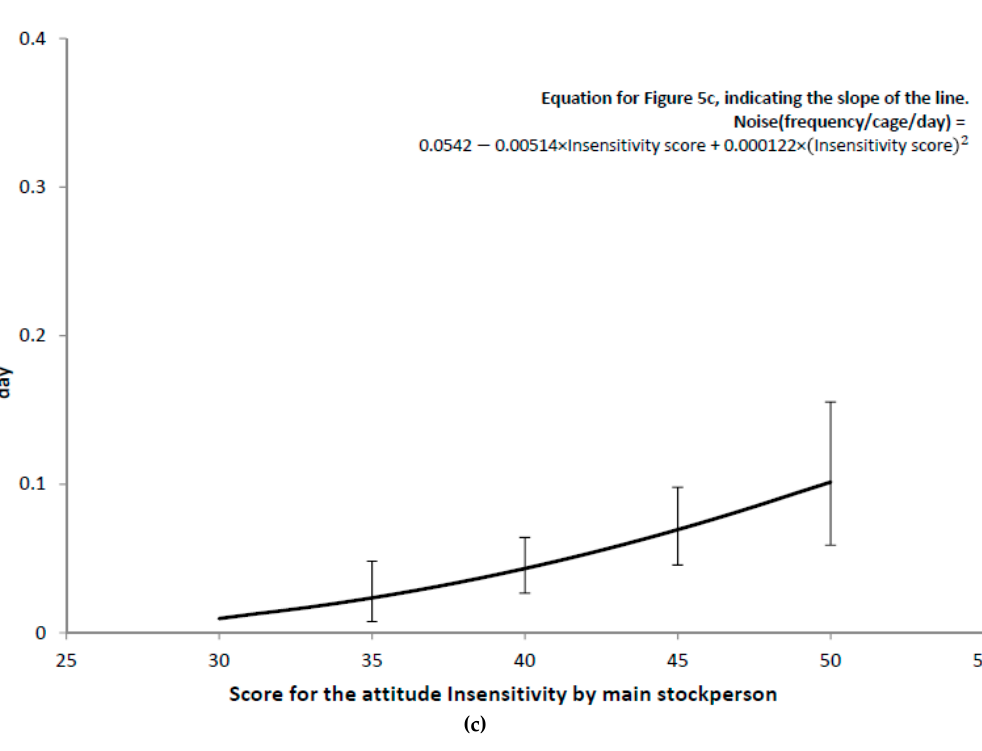
Figure 5. ( a ) Relationship between main stockperson noise and all stockperson entries per cage, after adjusting for stockperson positive attitude score and stockperson insensitivity attitude score. ( b ) Relationship between main stockperson noise and main stockperson positive attitude score, after adjusting for square root of all stockperson entries per cage and stockperson insensitivity attitude score. ( c ) Relationship between main stockperson noise and main stockperson insensitivity attitude score, after adjusting for square root of all stockperson entries per cage and stockperson positive attitude score. Error bars represent 95% confidence intervals.